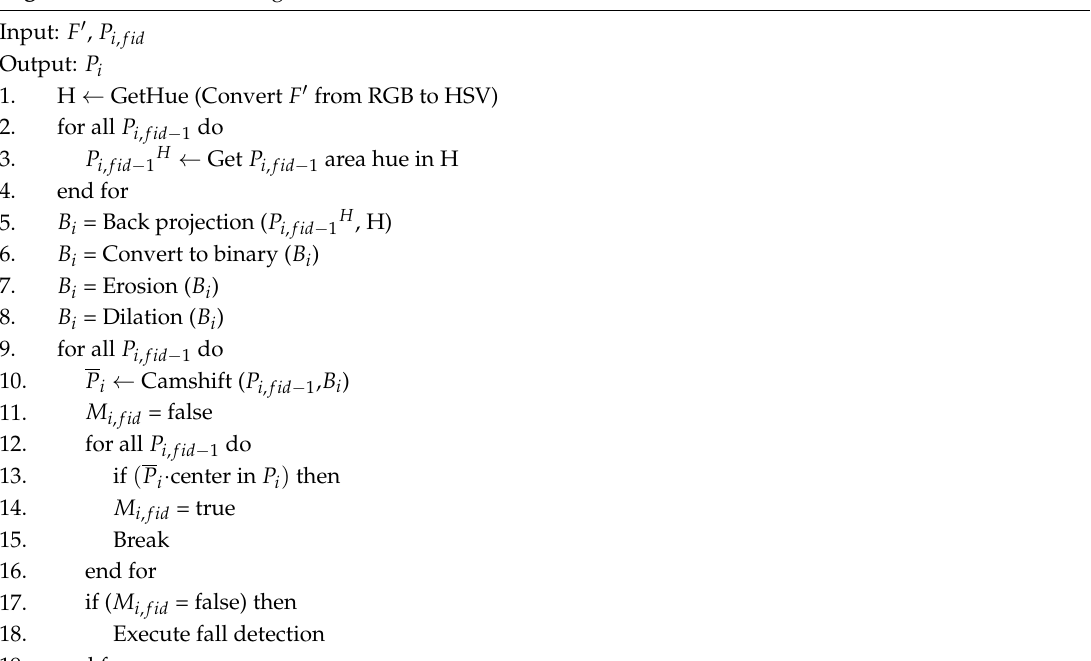
Algorithm 2 Person